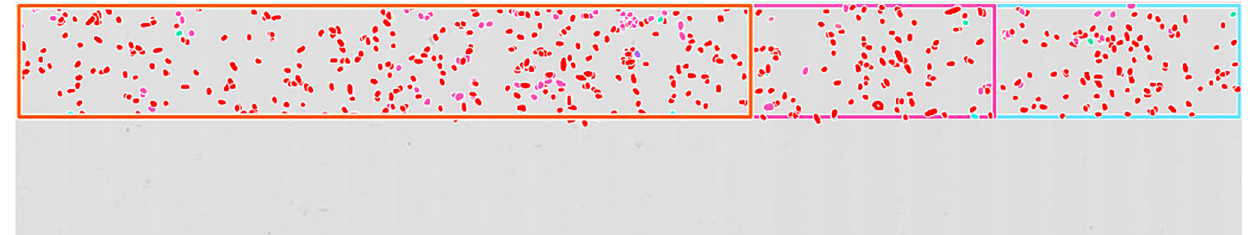
Fig 3. Screenshot of a vertically cropped area of an annotated virtual slide image. The original size of the complete virtual slide is approximately 55,000 x 39,000, the size of the depicted clipping 55,000 x 11,000 pixel. In the upper part of the image about 500 diatom objects were annotated (colored spots) and subdivided into training, validation and evaluation subsections (orange, pink and cyan rectangles, respectively).